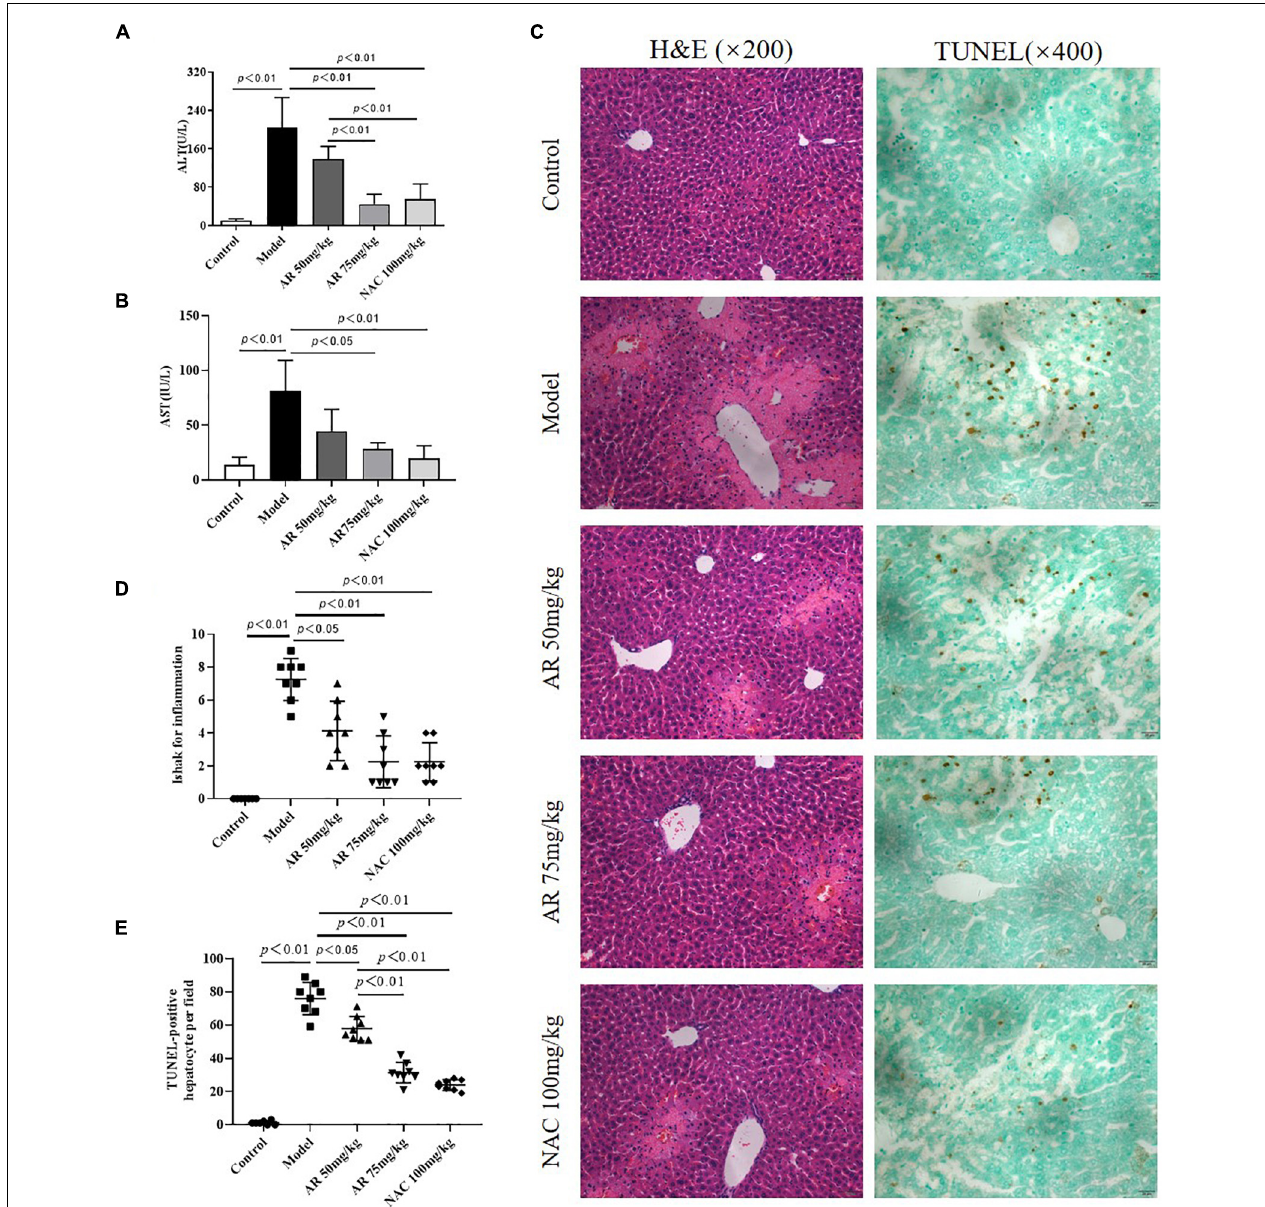
FIGURE 6 | Astragali Radix treatment attenuates APAP-induced liver injury in vivo . Mice were administered intragastrically with AR (50, 75 mg/kg body weight) or N -acetyl- L -cysteine (NAC, 100 mg/kg body weight) once a day for three consecutive days. Then APAP was dissolved in 5% carboxymethylcellulose sodium in water and given intragastrically with 350 mg/kg body weight as noted in the protocol. Twelve hours after APAP administration, all mice were sacrificed. Serum ALT (A) and AST levels (B) in AR or NAC treated and untreated mice. (C) Representative HE-stained (200 × ) and TUNEL-stained (magnification 400 × ) sections of liver tissue from AR or NAC treated and untreated mice 12 h after APAP administration. (D) Ishak scores for inflammation from AR treated and untreated mice. (E) TUNEL-positive hepatocyte of five high-power fields at × 400 magnification in each tissue